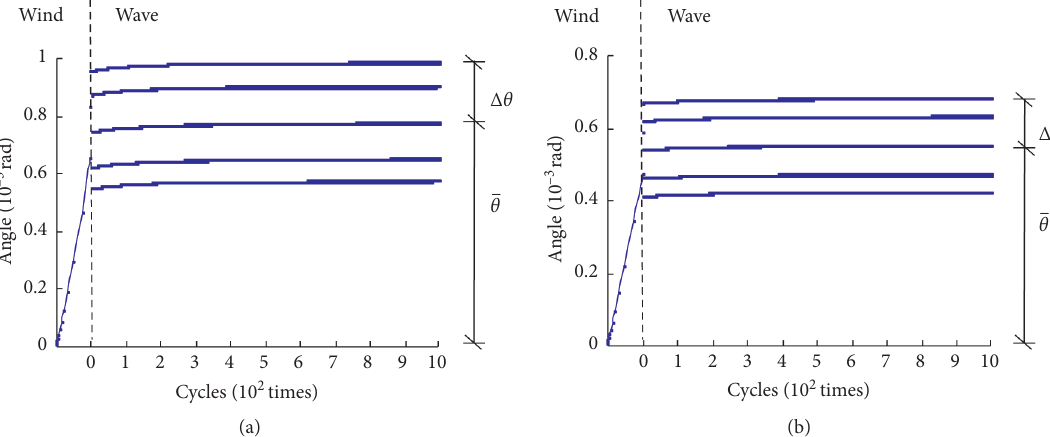
Figure 8: Relation of rotation and cyclic numbers of bucket foundation of aspect ratio L / D � 0.6. (a) Imperfect interface. (b) Full